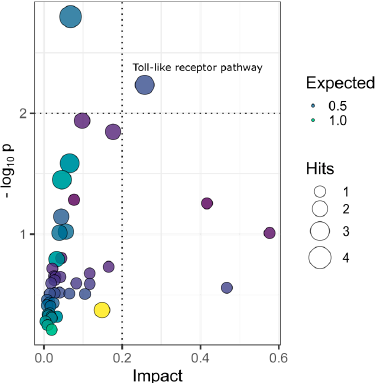
Figure 6. KEGG pathway analysis based on combining DEGs and DMs.